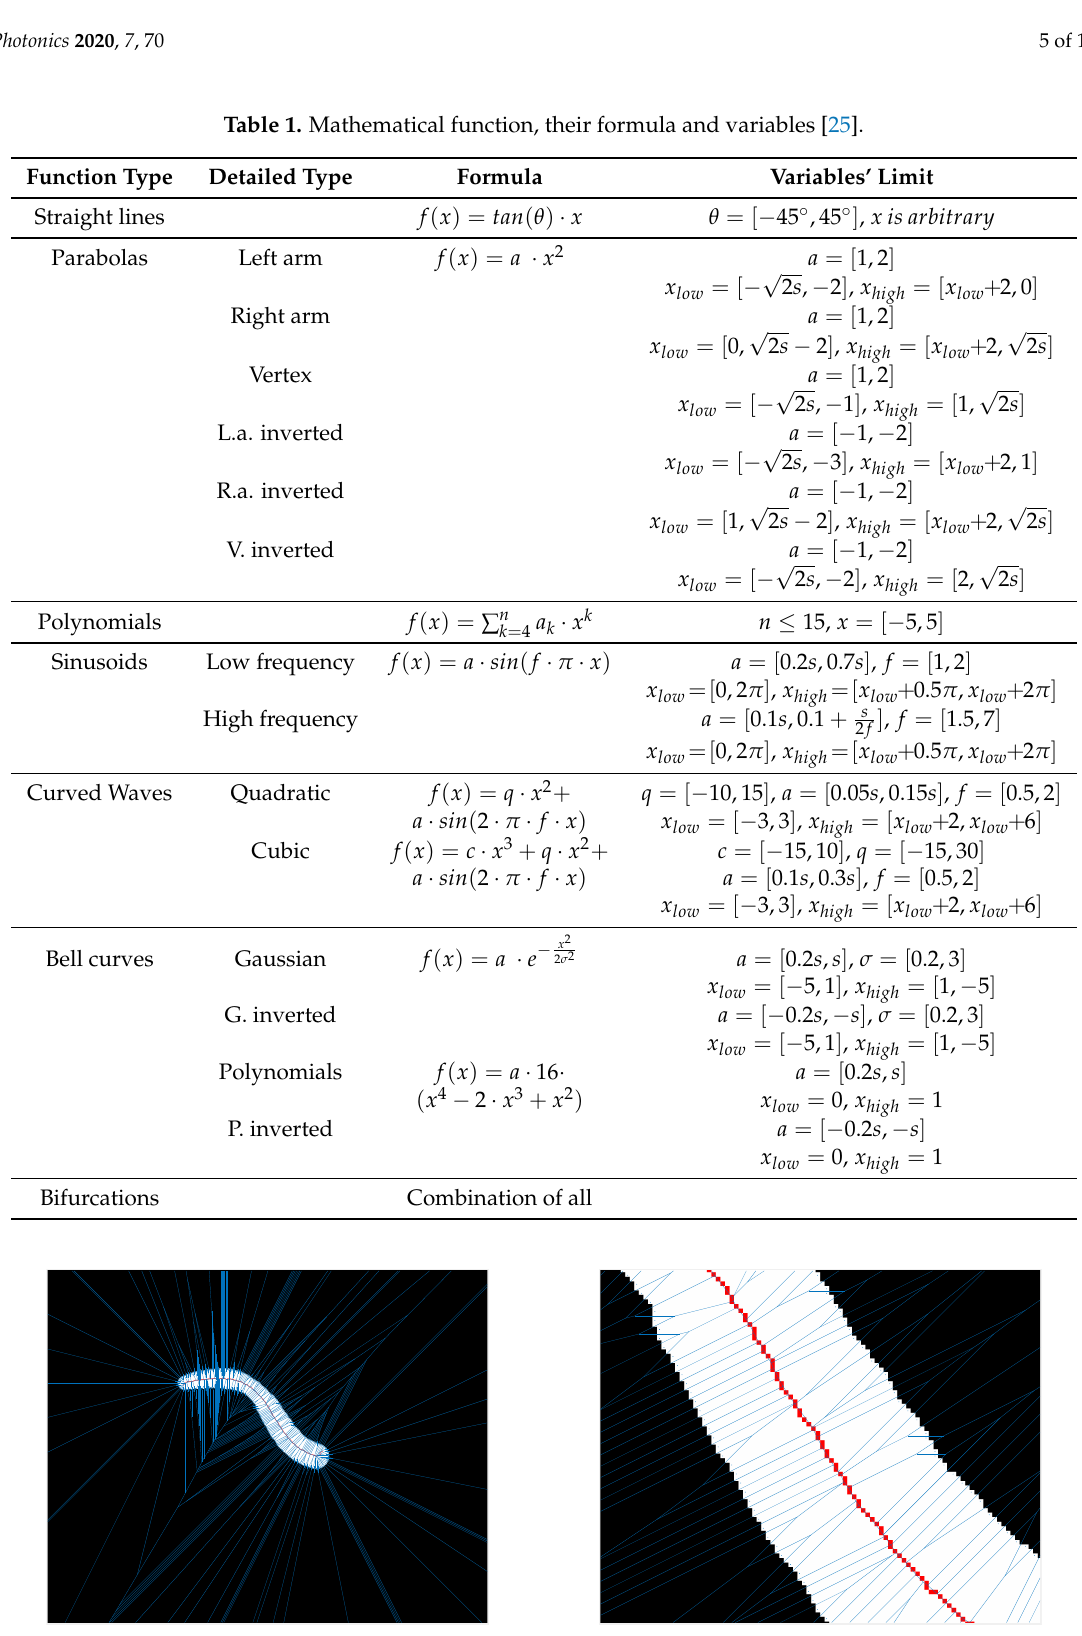
Figure 2. To the left the Voronoi diagram of a segmentation mask, to the right a zoom into a section of this diagram—blue are the Voronoi edges, red is the centerline extracted from the Voronoi